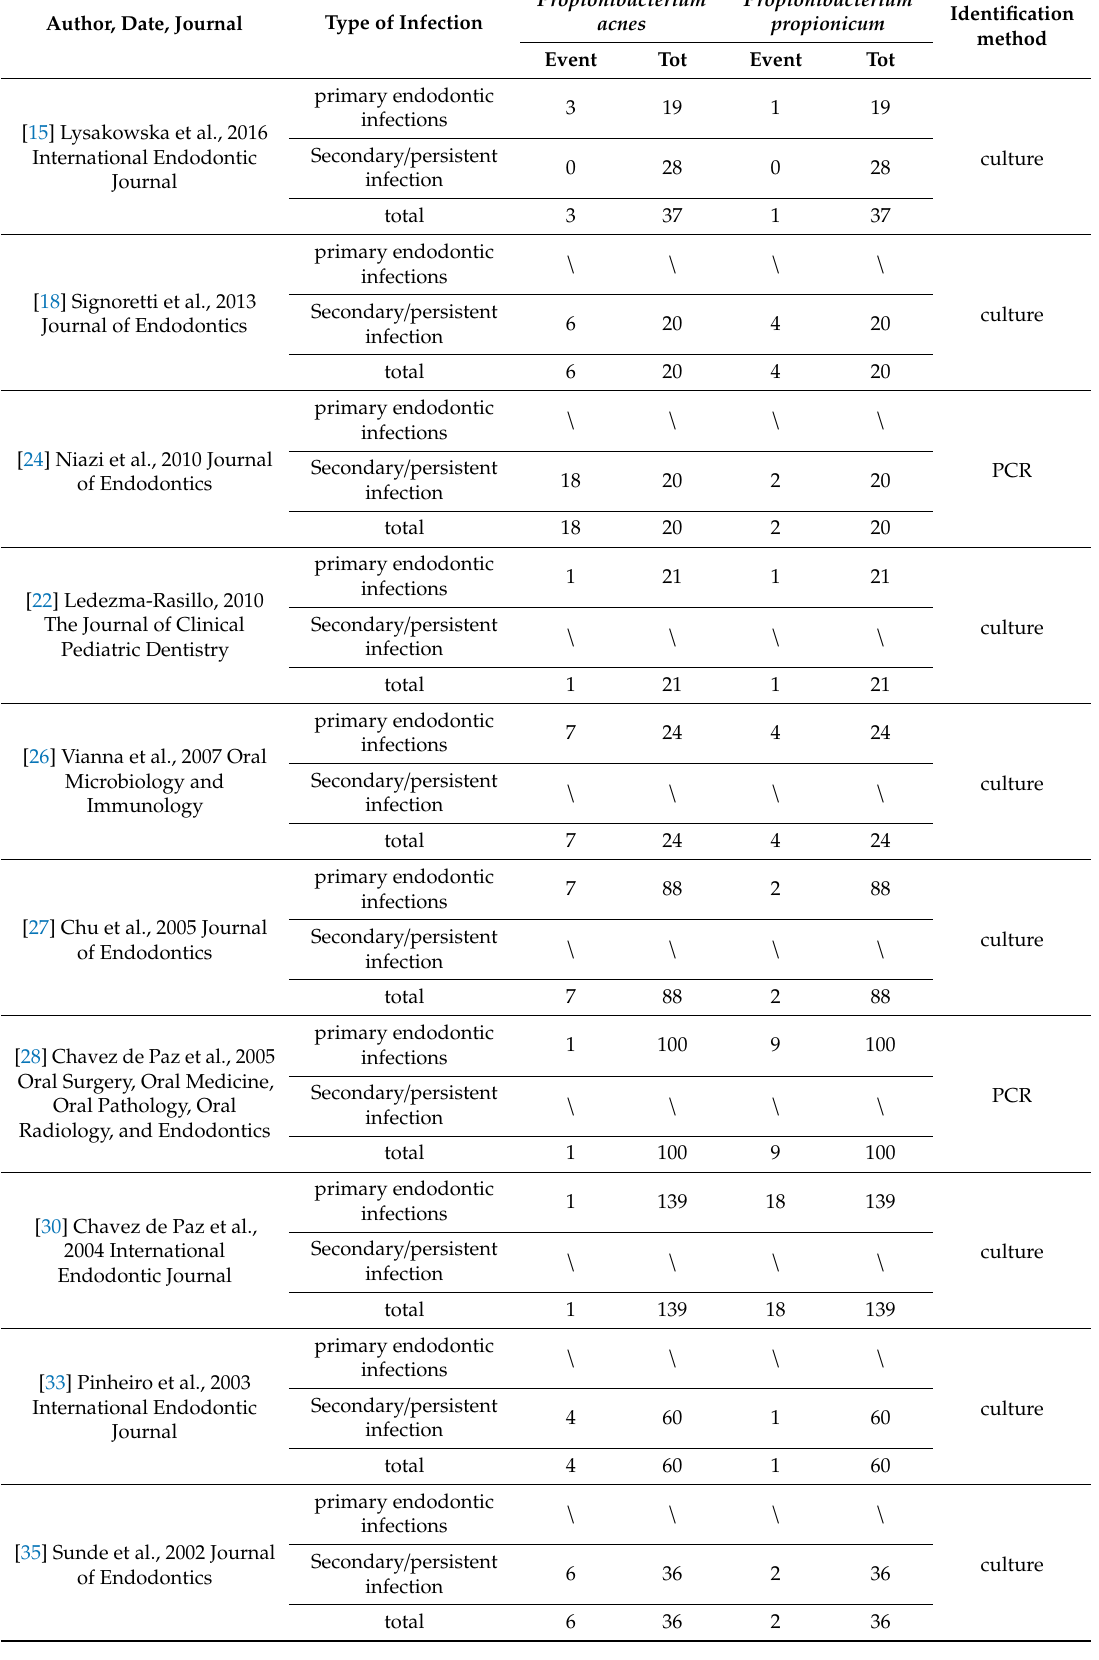
Table 5. Tertiary outcome di ff erence in the prevalence of Propionibacterium Acnes compared to Propionibacterium propionicum in endodontic